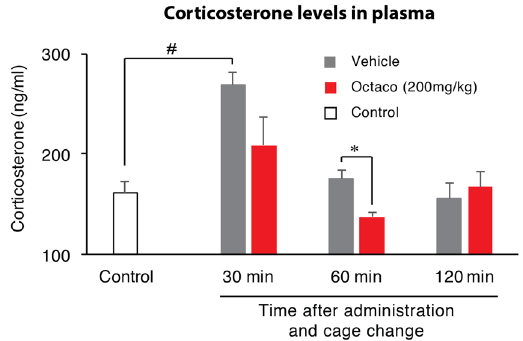
Figure 4. Changes in blood corticosterone levels (stress) after octacosanol administration in mice. Graph shows blood plasma corticosterone levels, after vehicle (gray bars) and octacosanol (200 mg/kg; red bars) administration in mice at various time points. Open bar represents control (no cage change). Data presented as mean ± SEM; n = 4–5; # p ≤ 0.05 vs control, by using one-way ANOVA followed by Scheffe post hoc test, and * p ≤ 0.05 vs vehicle by using paired t-test. Octaco: octacosanol, ns: not